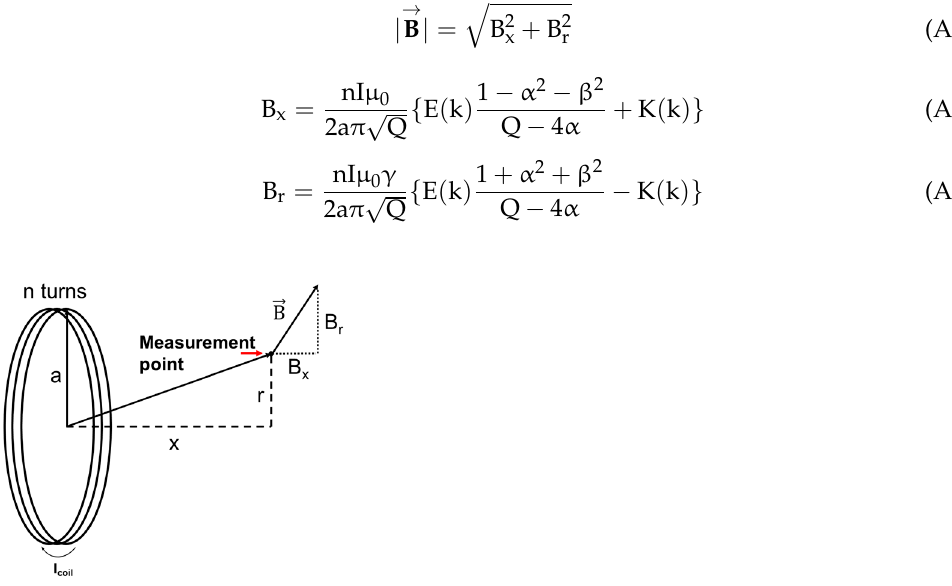
Figure A1. Magnetic field produced by a circular coil.